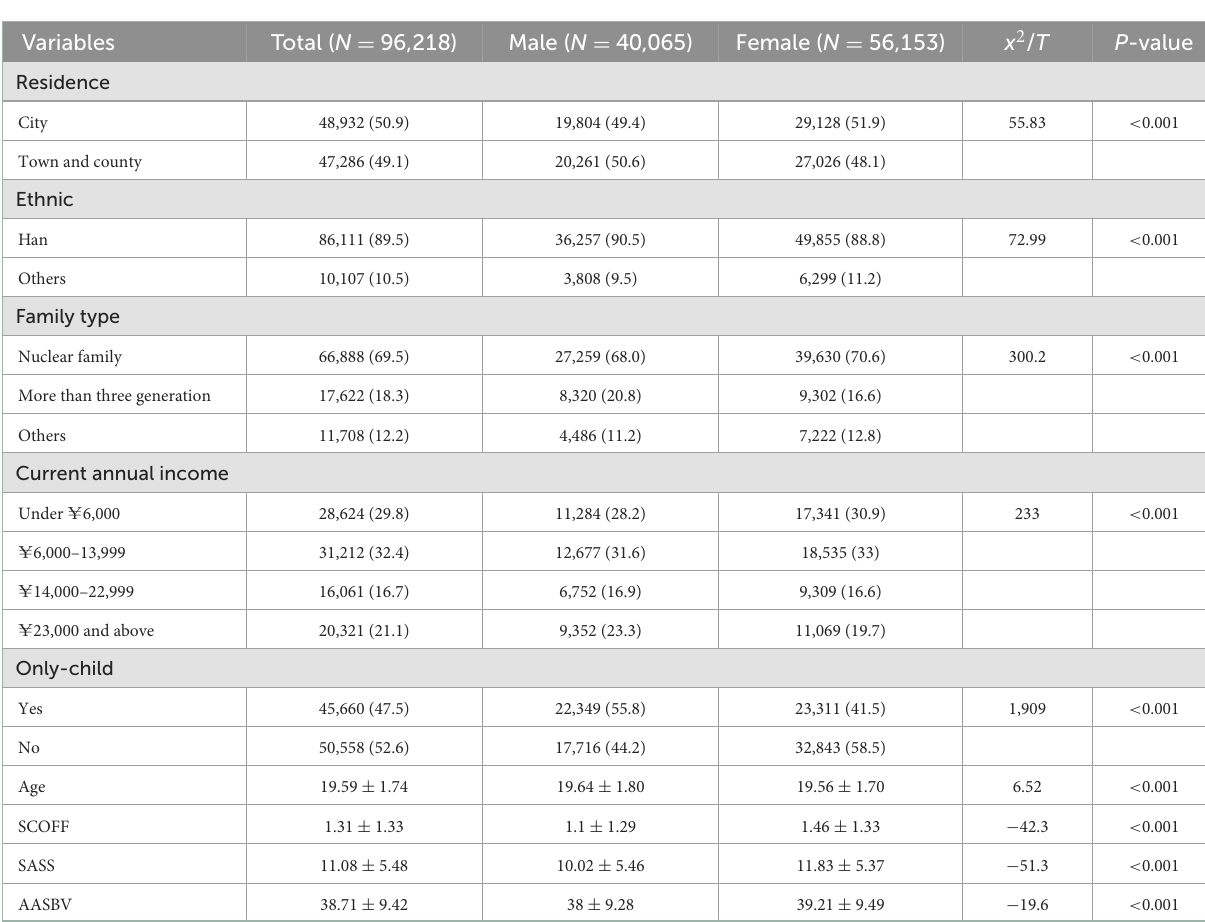
TABLE 1 Descriptive statistical